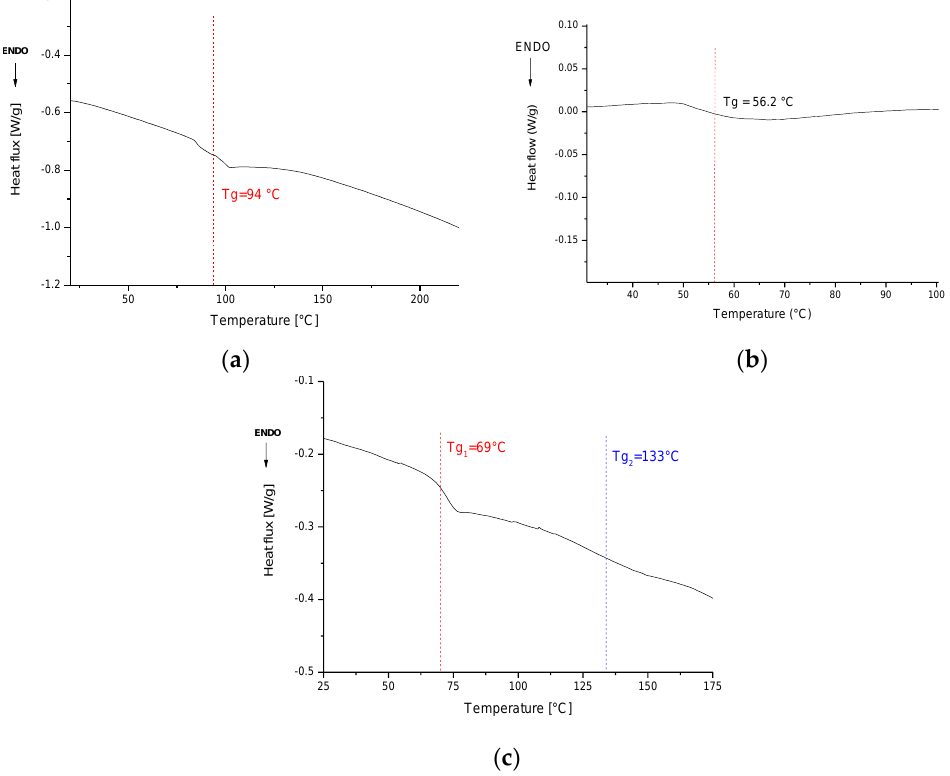
Figure 3. DSC: on epoxidized waste flour sample (EWFm) ( a ); on recycled EWF matrix (rEWFm) ( b ); on CF composite sample ( c ) .